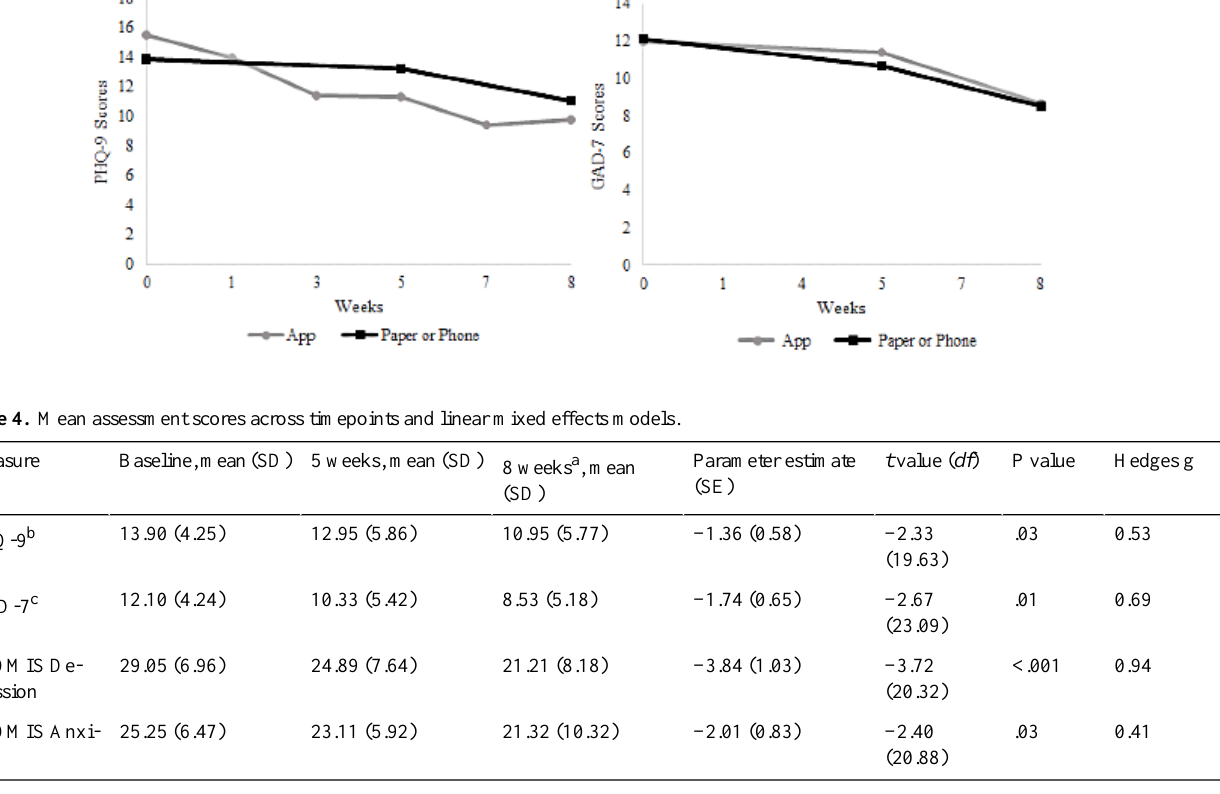
PHQ-9: Patient Health Questionnaire 9-item. c GAD-7: Generalized Anxiety Disorder